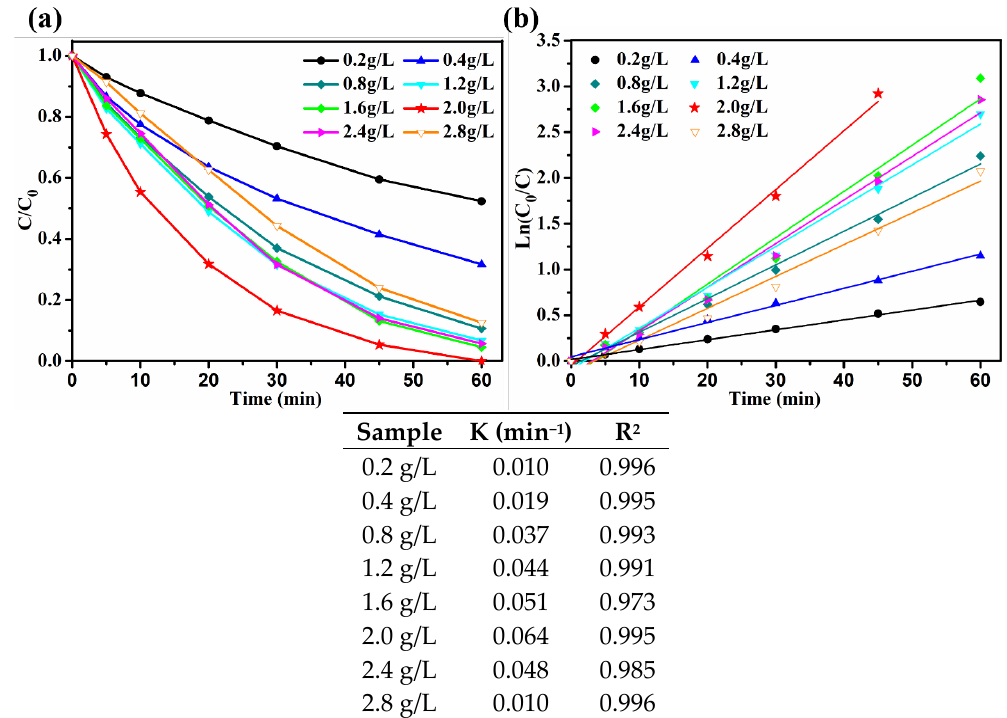
Figure 7. ( a ) Effect of varying nano-TiO 2 concentration on ATL degradation, ( b ) Pseudo- first-order model. The initial ATL concentration of 18.77 µM and mixed phase concentration of 2.0 g/L; pH: 7.6; temperature: 20 °C.